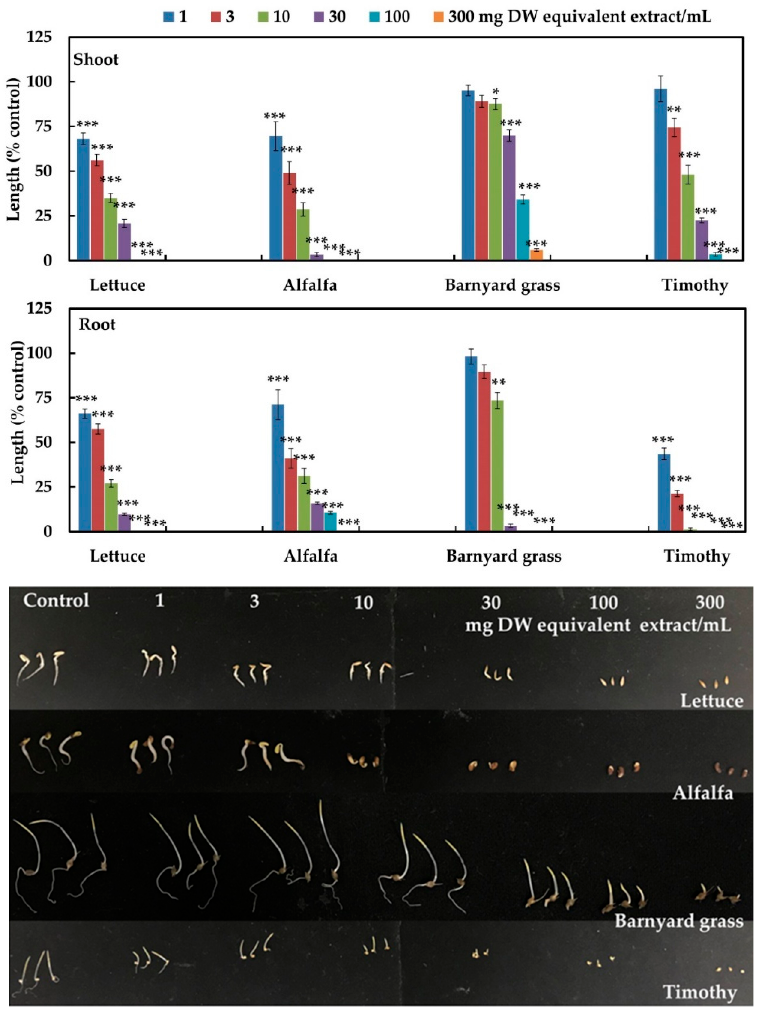
Figure 2. Effects of aqueous methanol extracts of Marsdenia tenacissima leaves on the root and shoot growth of le tt uce, alfalfa, barnyard grass, and timothy with the concentrations corresponding to the extracts acquired from 1, 3, 10, 30, 100, and 300 mg DW equivalent extract/mL. The bars on each experiment show mean ± SE from two independent experiments with three replications and 10 plants for each treatment ( n = 60). Asterisks indicate signi fi cant di ff erence between control and treat- ment: * p < 0.05, ** p < 0.01, *** p < 0.001.